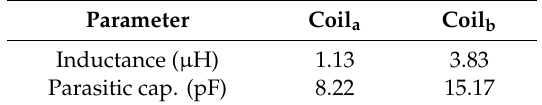
Figure 6. The experimental array of the coils: ( a ) Two coils; ( b ) three coils; and ( c ) four coils.